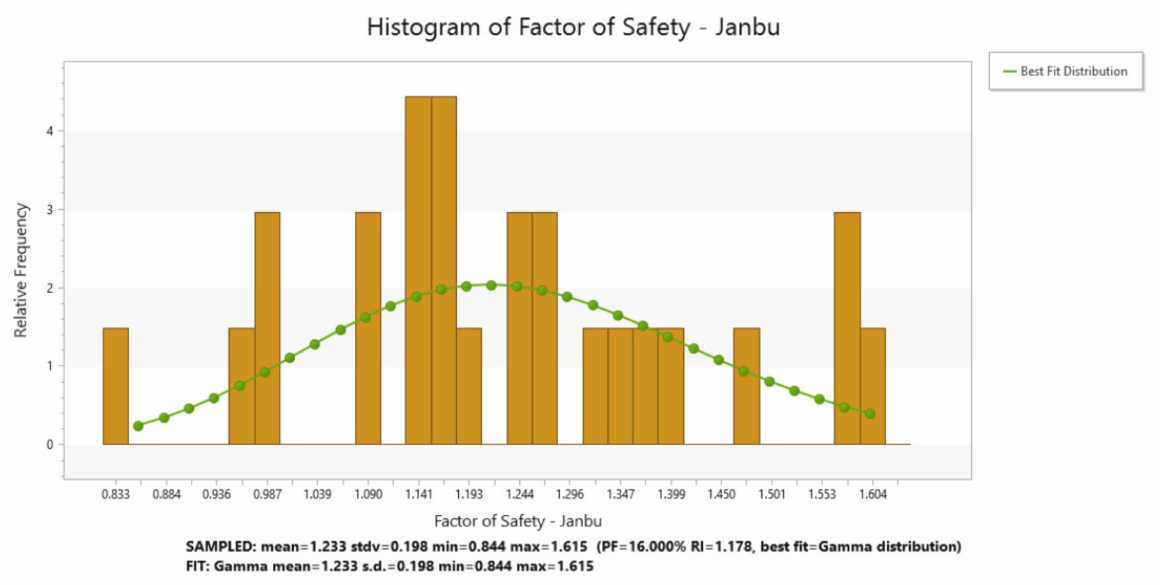
Figure 18. Histogram of the FoS from the 3D probabilistic